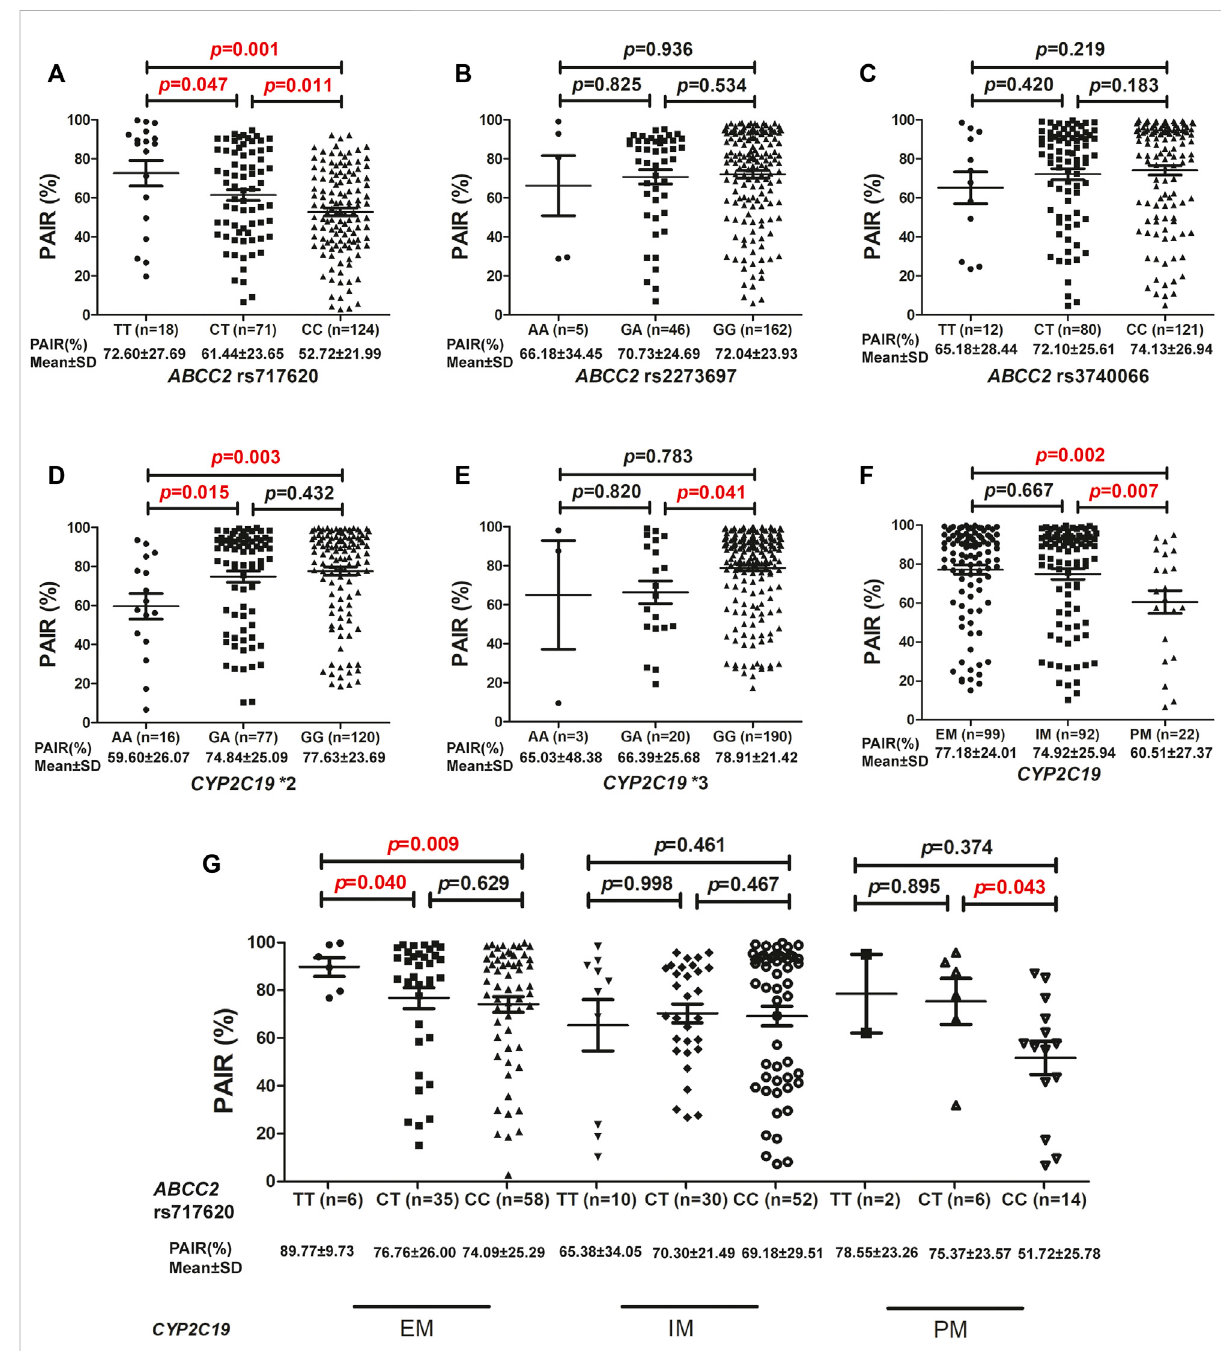
FIGURE 1 Association between ABCC2 and CYP2C19 based on PAIR% values. Association between PAIR% values and (A) ABCC2 rs717620, (B) ABCC2 rs2273697, (C) ABCC2 rs3740066, (D) CYP2C19 *2, (E) CYP2C19 *3, and (F) CYP2C19 metabolic phenotype distributions. (G) In fl uence of ABCC2 rs717620polymorphismonthePAIR%valuesofdifferent CYP2C19 metabolicphenotypes. PAIR(%),